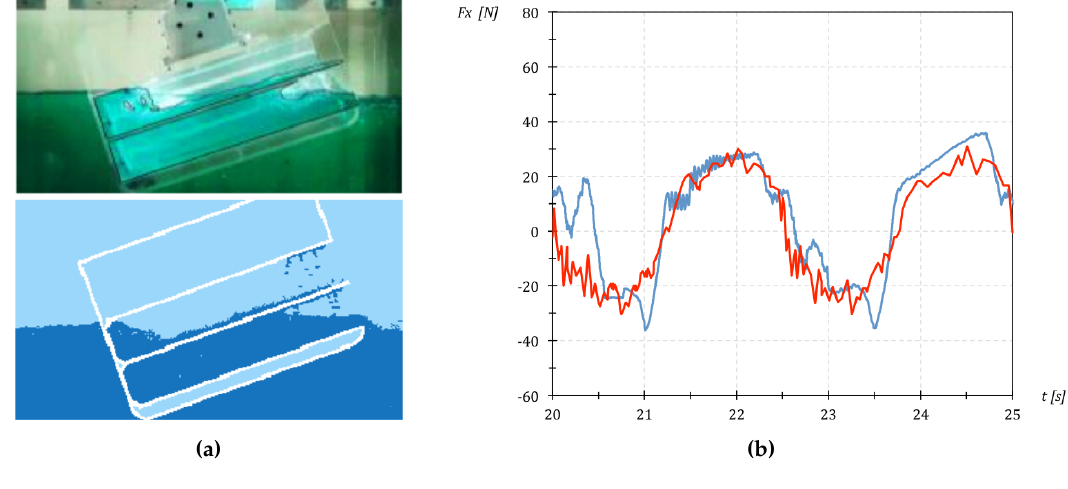
Figure 8. Selected figures from the ASM project work of Budde, Conradi and Lüke on flooding simulations with ELBE: ( a ) comparison of experimental (top) and numerical (bottom) results for a damaged car deck; ( b ) comparison of fluid forces of experiment (red) and simulation (blue). A grid with 1280 times 256 nodes was used. Twenty six seconds of real-time sloshing were simulated in less than one hour on a single